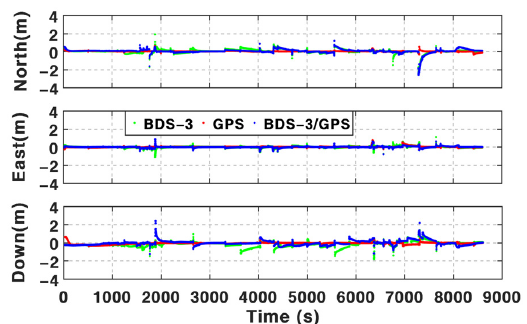
Figure 16. Positioning differences between undifferenced PPP/INS/ODO TCI and BSSD PPP/INS TCI/ODO .